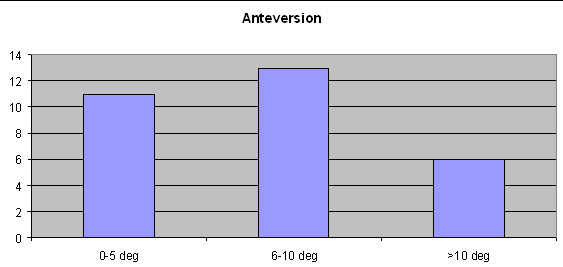
The numbers of cups placed within 5 degrees, 6-10 degrees and more than 10 degrees of the intra-operative final cup placement anteversion readings as displayed by the navigation system are shown.